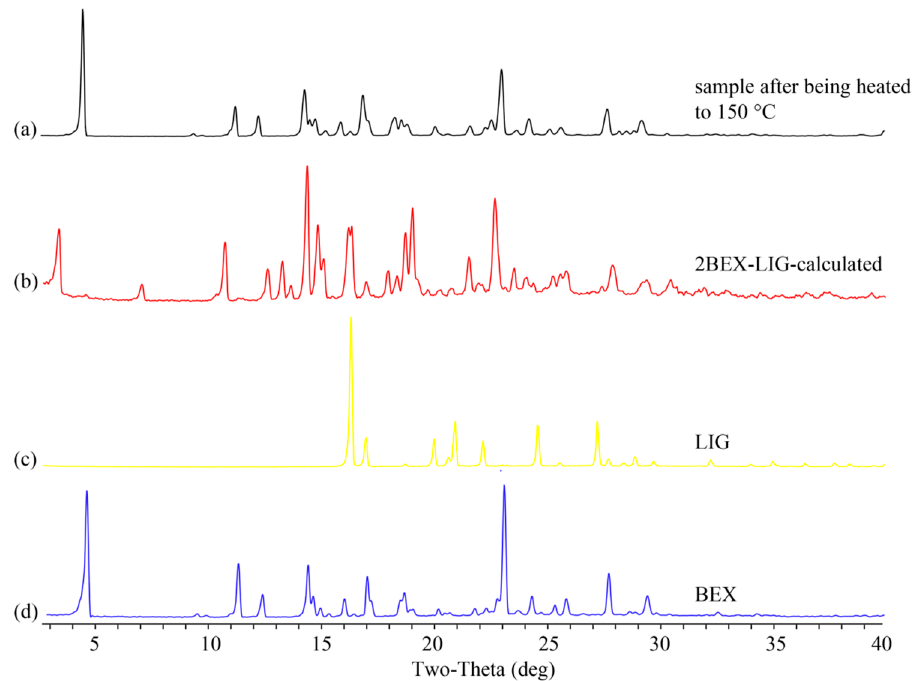
Powder X-ray di ff raction (PXRD) patterns of the samples: ( a ) sample after being heated to 150 ◦ C; ( b ) calculated 2bexarotene-ligustrazine (2BEX-LIG); ( c ) ligustrazine (LIG); and ( d ) bexarotene (BEX).